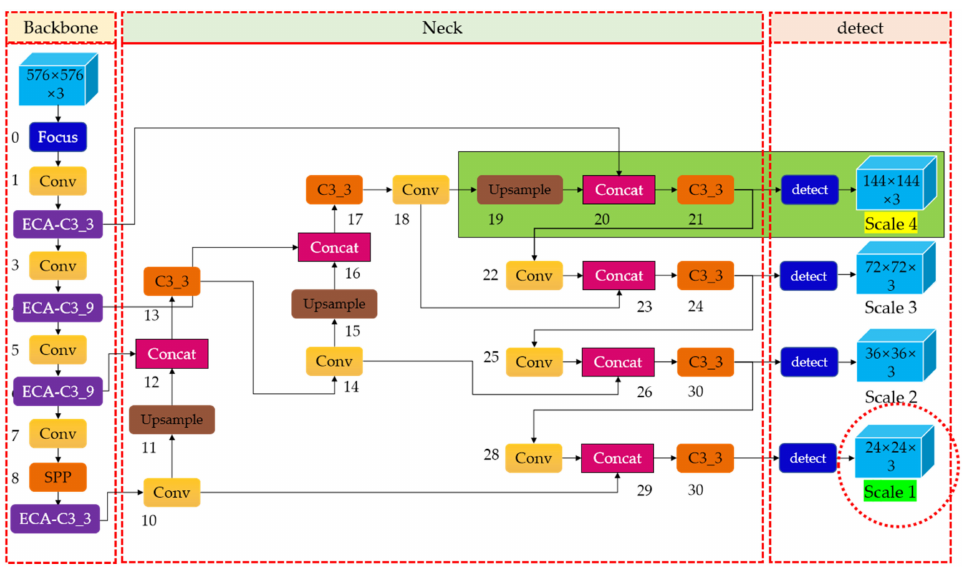
Figure 6. The architecture of the